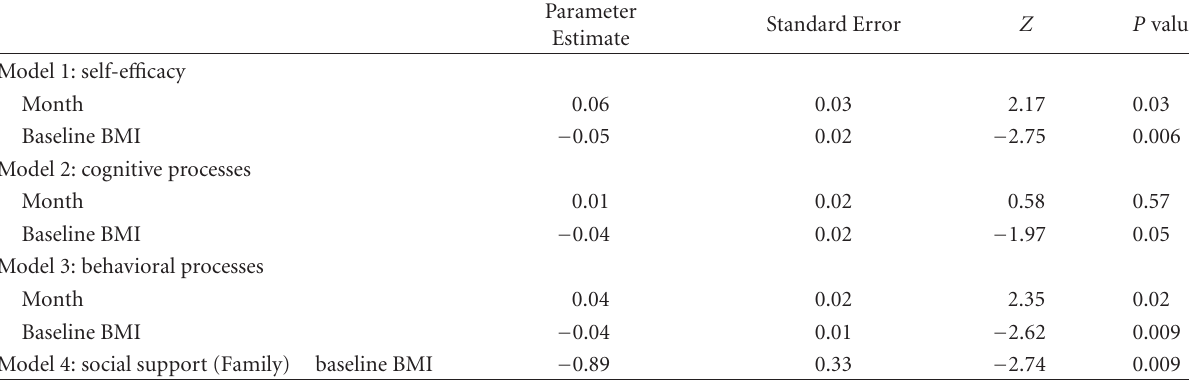
Table 2: E ff ects of time and baseline BMI use on targeted theoretical constructs over time ( n =